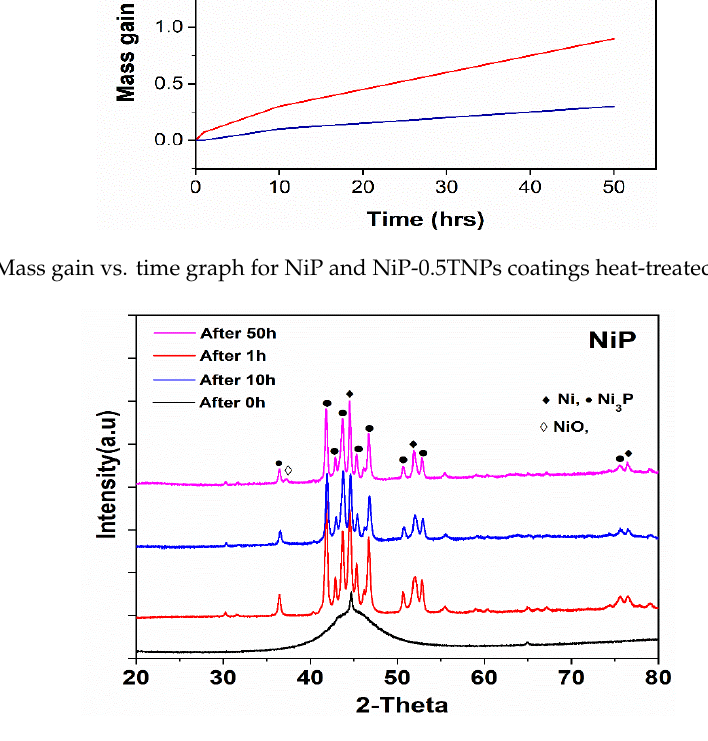
Figure 14. XRD spectra of NiP coatings after heat treatment in air at different time intervals.